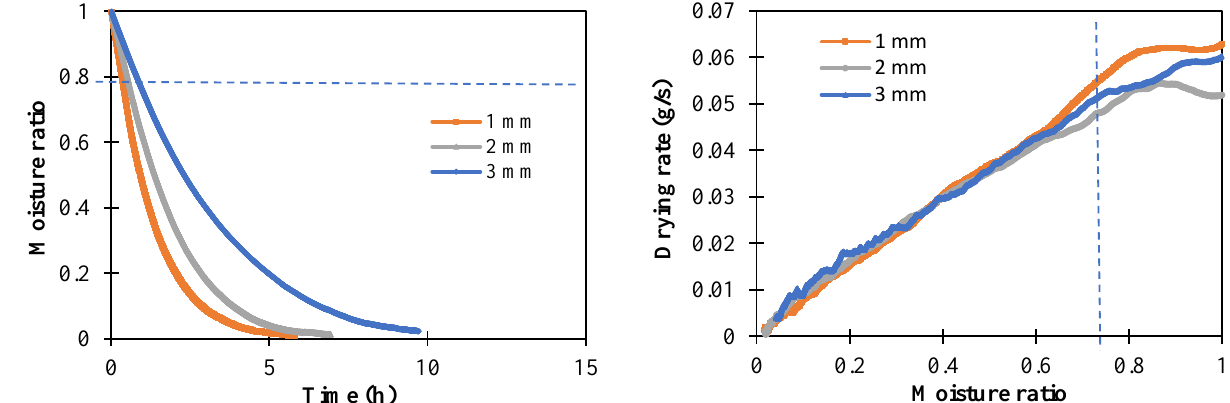
Figure 3. Drying kinetics of apple slices of different thicknesses (100% load — 0.5 m/s — 52% RH). It follows that within the first 30 min of drying (1 < MR < 0.8), there were linear drying kinetics, which indicated a constant drying rate period. This behavior was observed in both EHD and hot air drying. Hence, the drying rate was determined as the slope of